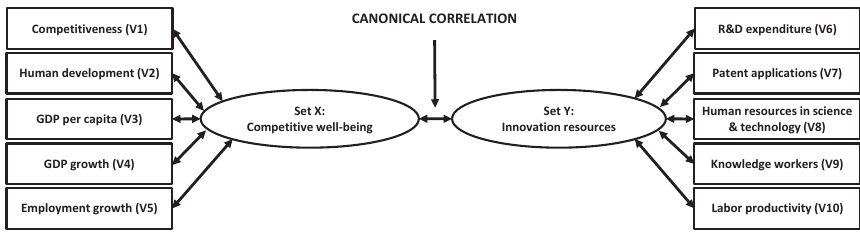
Figure 1. The competitive well-being framework designed by the authors the overlaps OECD’s (2017) well-being framework, where resources are required for sustainable well-being, while in our approach, innovation resources build competitive well-being.